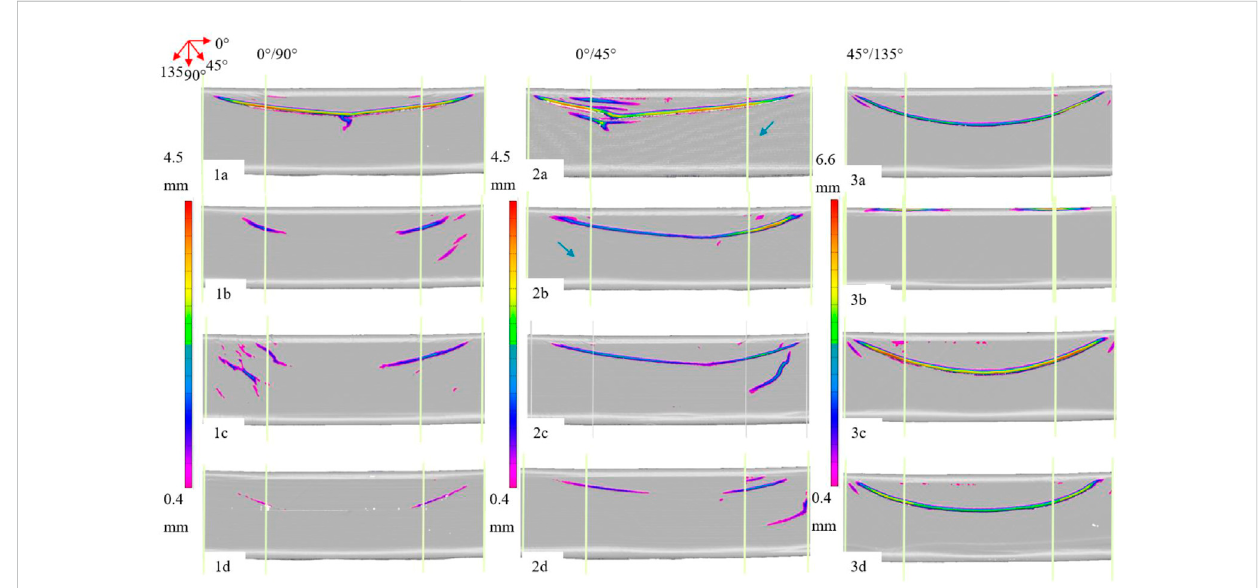
FIGURE 4 Frontal web view of 3D preform scans showing wrinkle height colour maps and location relative to ramps on